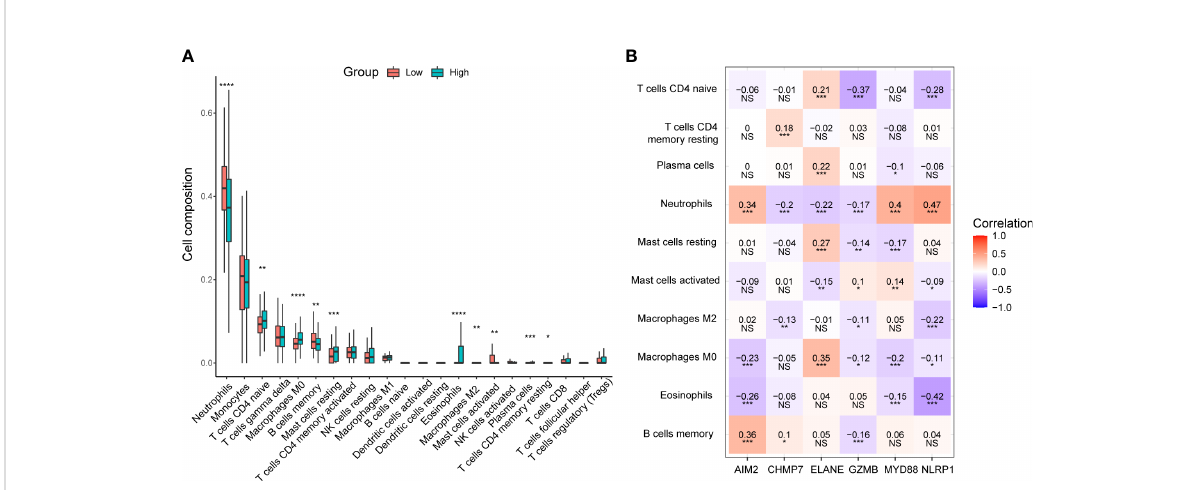
FIGURE 7 Immune in fi ltration analysis between low- and high-risk groups in the GSE65682 dataset. (A) Box plots of 22 types of immune cell composition between low- and high-risk groups. * P < 0.05; ** P < 0.01; *** P < 0.001; **** P < 0.0001. (B) The correlation between the selected six pyroptosis- related genes and the immune cells. NS, Not signi fi cant, * P < 0.05; ** P < 0.01; *** P <